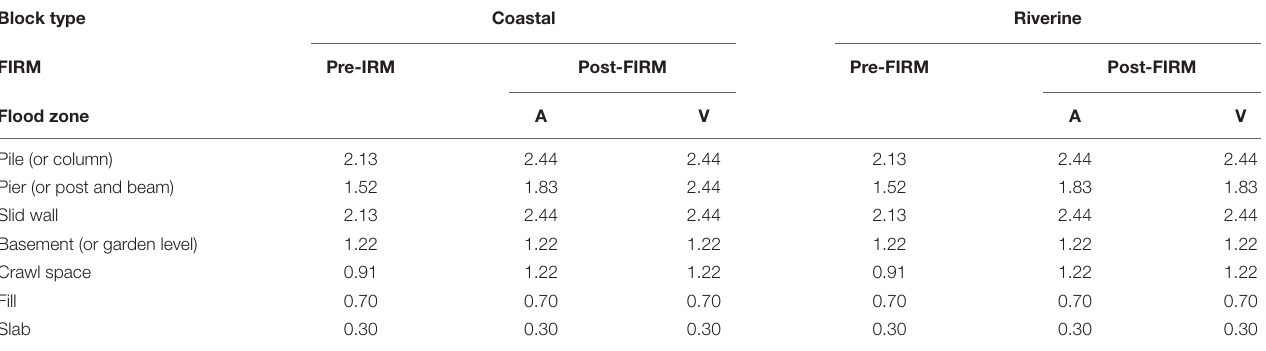
TABLE 3 | Default height (m) above grade to top of finished floor (FEMA, 2015). Block type